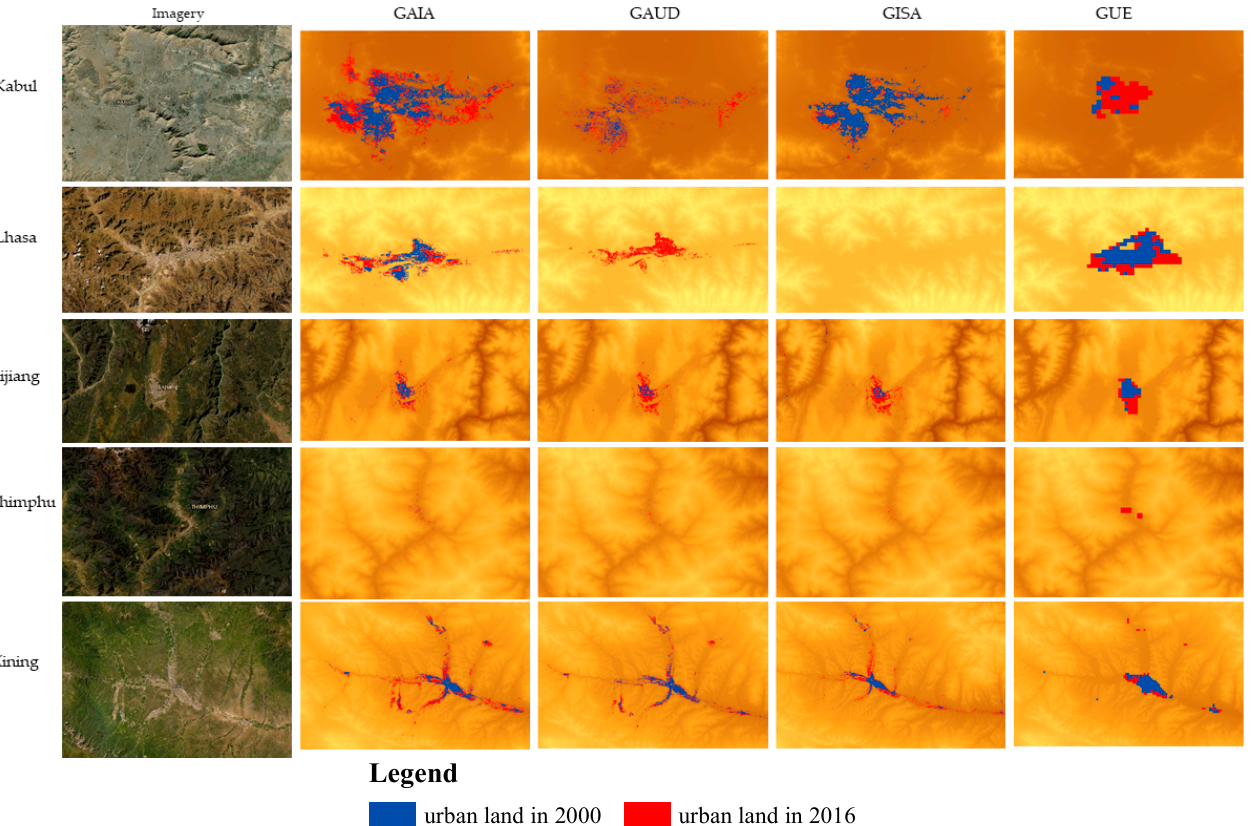
Figure 2. Urban expansion characteristics of the five representative cities between 2000 and 2016 shown by four ISA datasets.